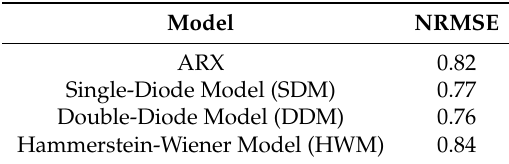
Table 4. Results for the proposed fail detection